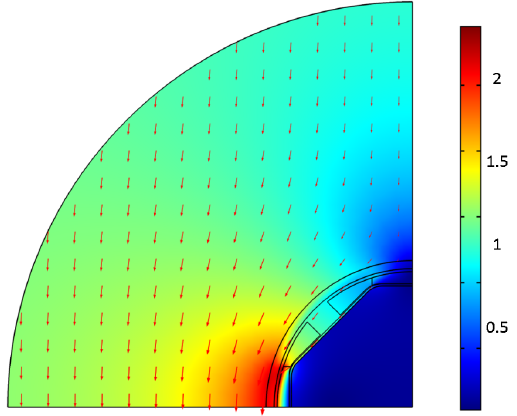
FIG. 7. Magnetic field map around the D1-type beam screen at 278 Hz. The color map, in T, is normalized to the input source. The red vectors represent the magnetic field